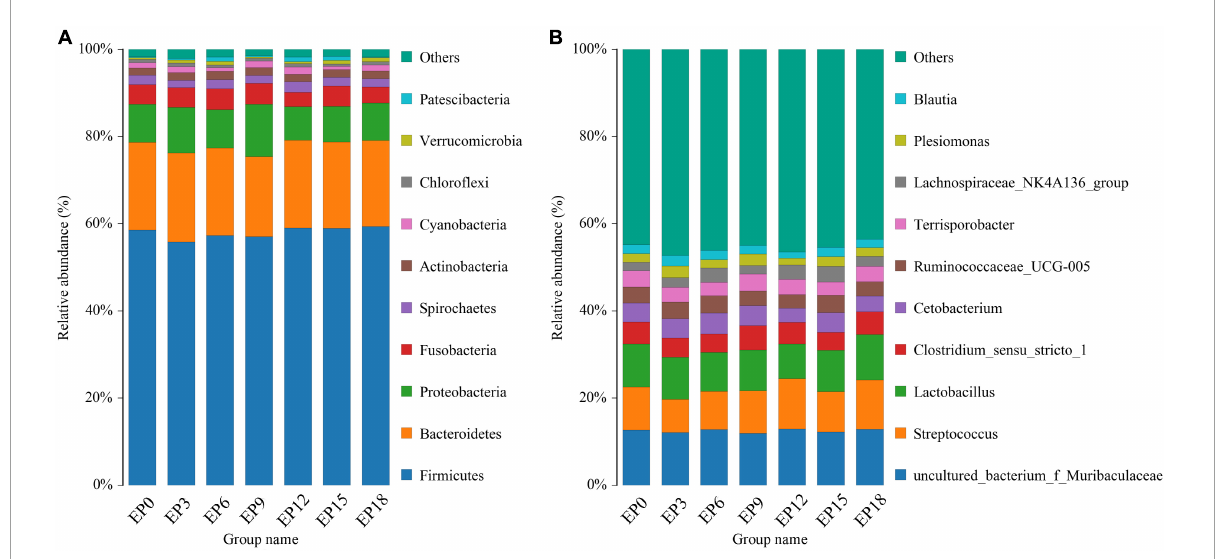
FIGURE6 Taxonomy classification of reads at the phylum (A) and genus (B) taxonomic levels of the intestinal microbiota in hybrid groupers fed with